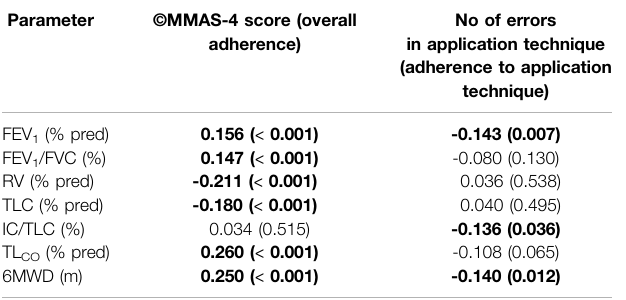
TABLE 5 | Correlations between Morisky Medication Adherence Scale (©MMAS- 4) score and the number of errors in application technique (Five Steps Assessment) with pulmonary functions (r; p -value).